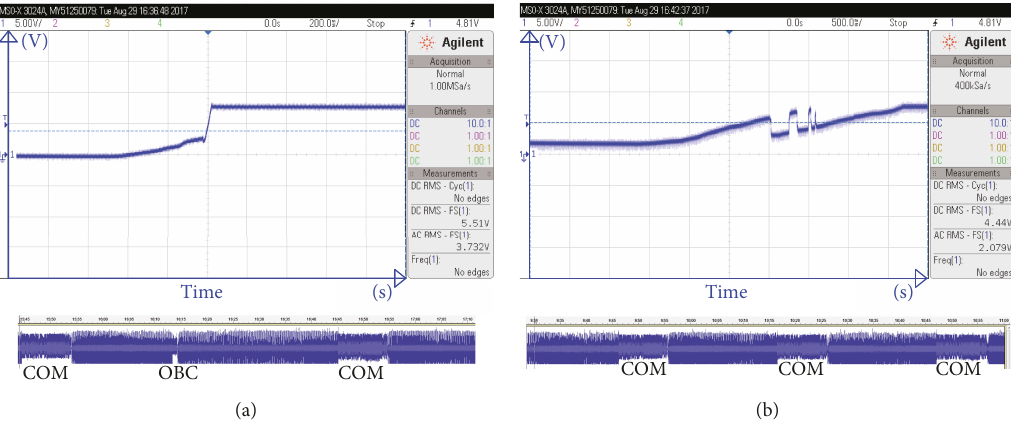
Figure 15: The left graph (a) shows an uneventful power-up sequence with an operational battery. Time division is 200mSec and voltage division is 2.5 V. The right graph (b) shows a power-up sequence with only a solar cell panel as power source. The panel is rotated into the sunlight with a rate of approximately 36 ° /sec. Time division is 500mSec, and voltage division is 2.5V. Inset below both graphs are the subsequent beacon patterns recorded with the DTUsat ground station.